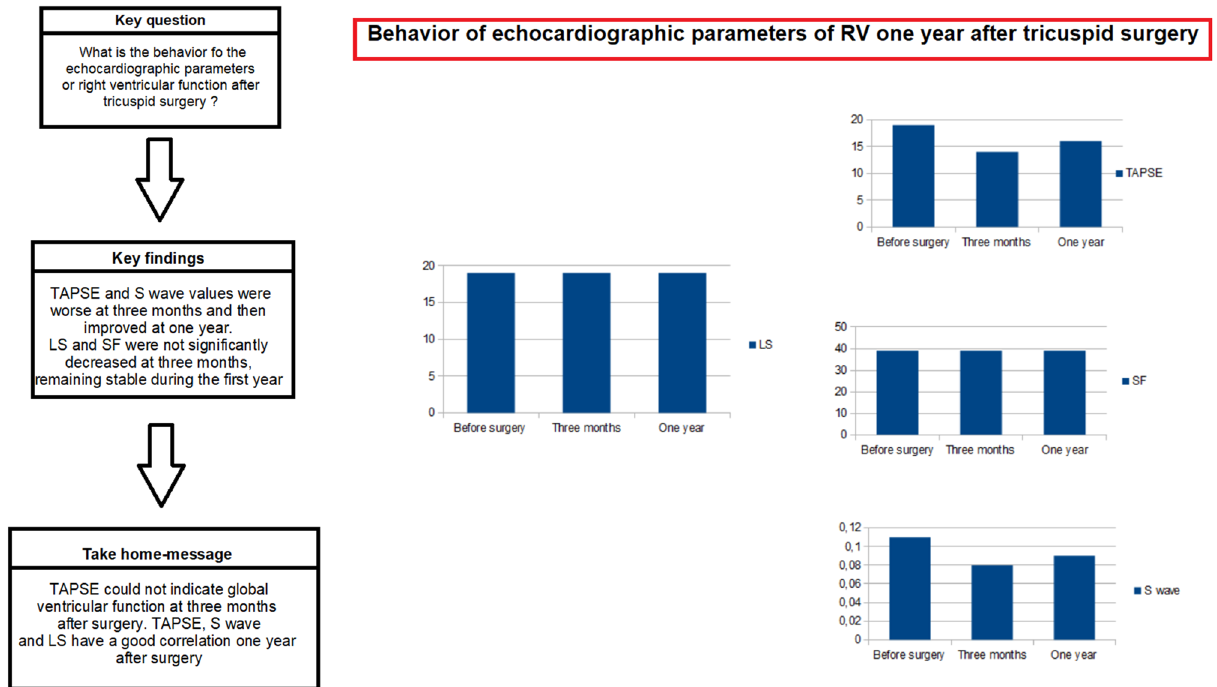
Figure 1. Behavior of the function of the right ventricle after tricuspid valve surgery.